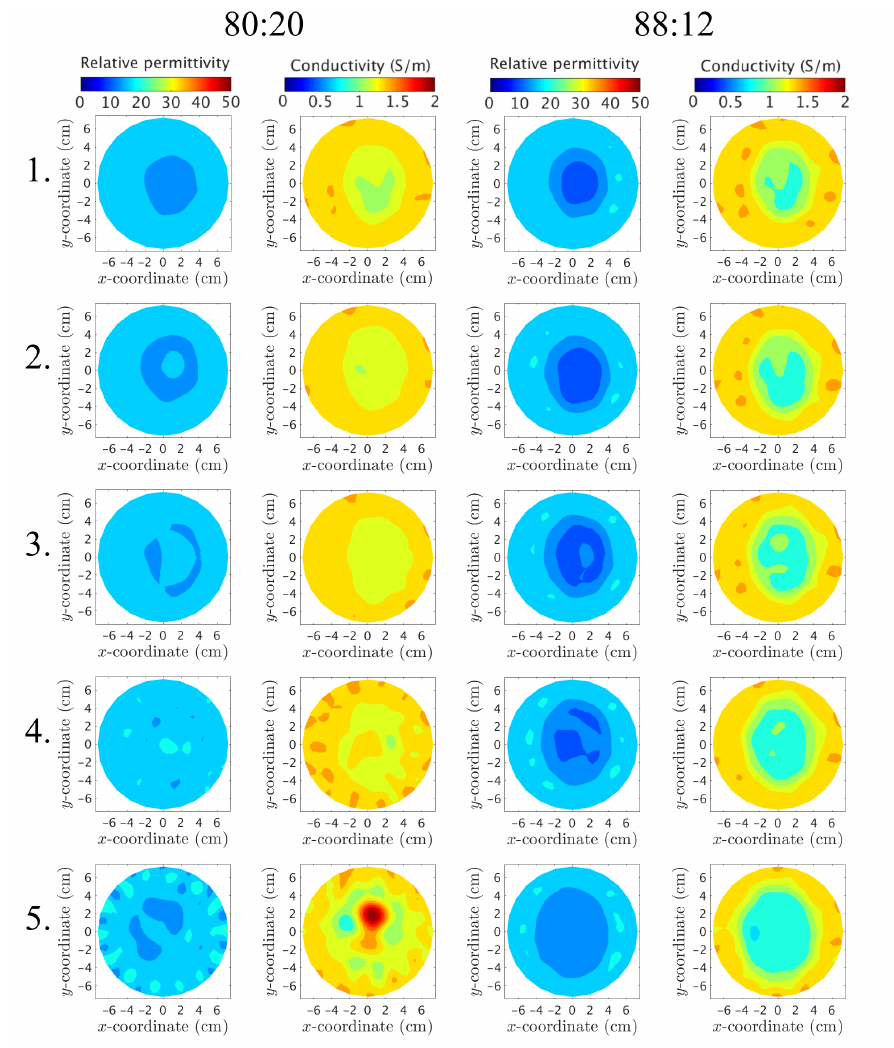
Figure 12. Reconstructed images at 1500MHz of the outer chamber. Each row depicts a layer of the phantom, starting from Layer 1 (closest to the nipple) up to Layer 5 (closest to the chest wall). The columns correspond to (from left to right) the permittivity using the 80:20 mixture, the conductivity for 80:20, the permittivity for 88:12, and the conductivity for 88:12,